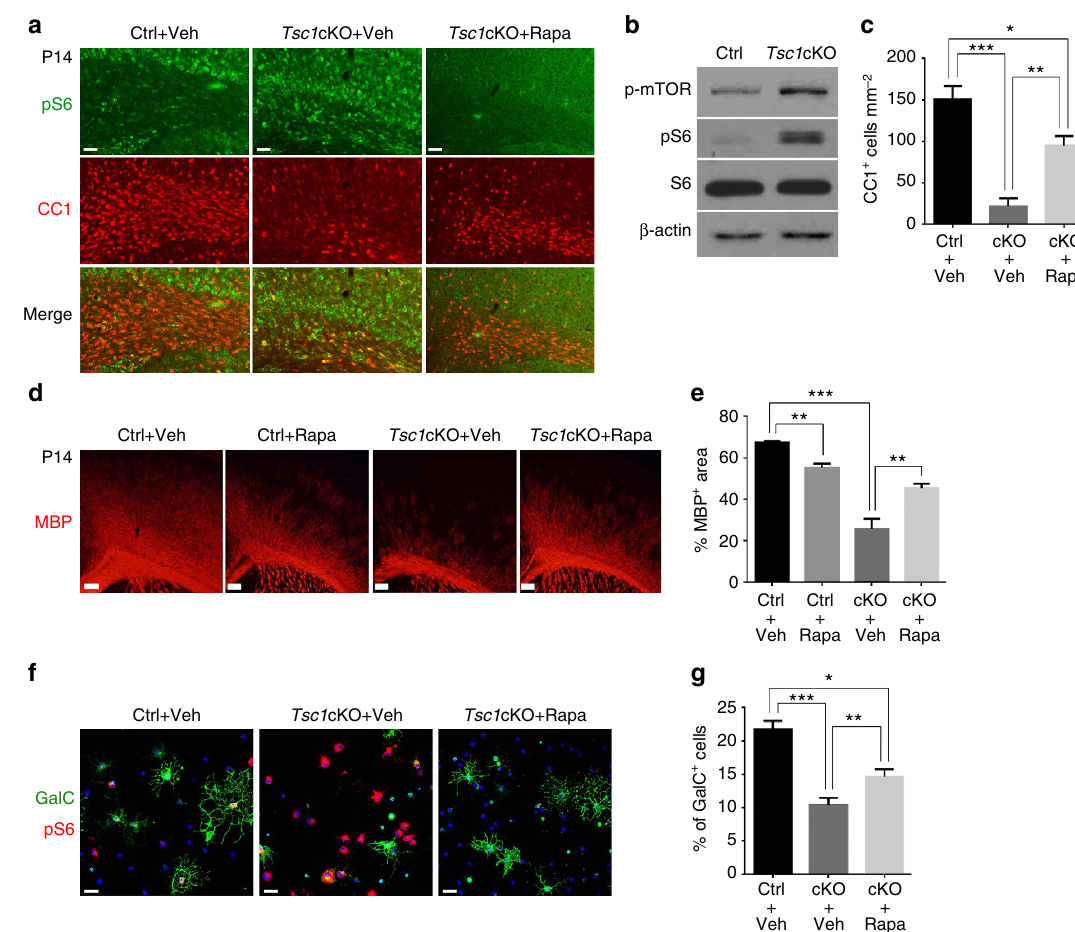
Figure 3 | Hyperactivation of mTOR signalling contributes to dysmyelination in Tsc1 mutants. ( a ) Representative images of the corpus callosum of control and Tsc1 cKO mutants treated with vehicle and rapamycin from P5 to P14 immunostained with p-S6 and CC1. Scale bar, 50 m m. ( b ) Lysates of control and Tsc1 cKO corpus callosum at P14 assayed by western blot using antibodies to MBP, p-mTOR, p-S6 and S6. b -actin was used as loading control. ( c ) The number of CC1 þ cells per mm 2 from the corpus callosum of control and Tsc1 cKO mice-treated vehicle and rapamycin. Data represent the mean ± s.e.m from four animals per genotype. * P o 0.05; ** P o 0.01; *** P o 0.001, One-way analysis of variance (ANOVA) with Tukey’s multiple-comparison test. ( d ) The corpus callosum of control and Tsc1 cKO mutants at P14-treated vehicle and rapamycin from P5 to P14 was immunostained with MBP. Scale bar, 100 m m. ( e ) Percentage of MBP area in the cortex of control and Tsc1 cKO mice treated with vehicle or rapamycin. Data represent the mean ± s.e.m from four animals per genotype. * P o 0.05; ** P o 0.01; *** P o 0.001. One-way ANOVA with Tukey’s multiple-comparison test. ( f ) OPCs isolated from control and Tsc1 cKO mice were cultured in the differentiation medium for 24h with vehicle and rapamycin, and immunostained with GalC and p-S6. Scale bar, 50 m m. ( g ) The percentage of GalC þ cells in cultures of control and Tsc1 cKO OPCs. Data represent the mean ± s.e.m.